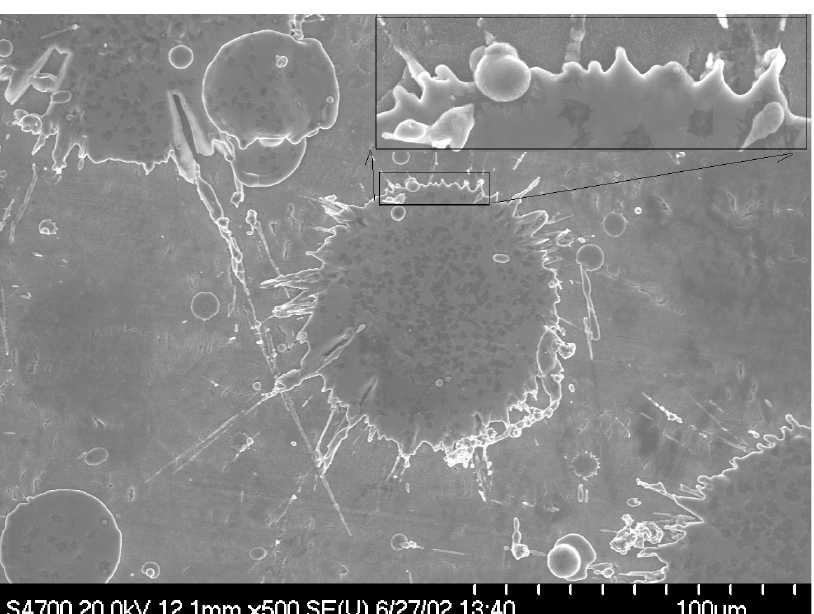
FIG. 22. A scanning electron microscope image of copper splattered on the inside of the window. The area covered is approximately 180 (cid:2) 250 (cid:16) m . The inset shows the fine structure of the bumps ringing the